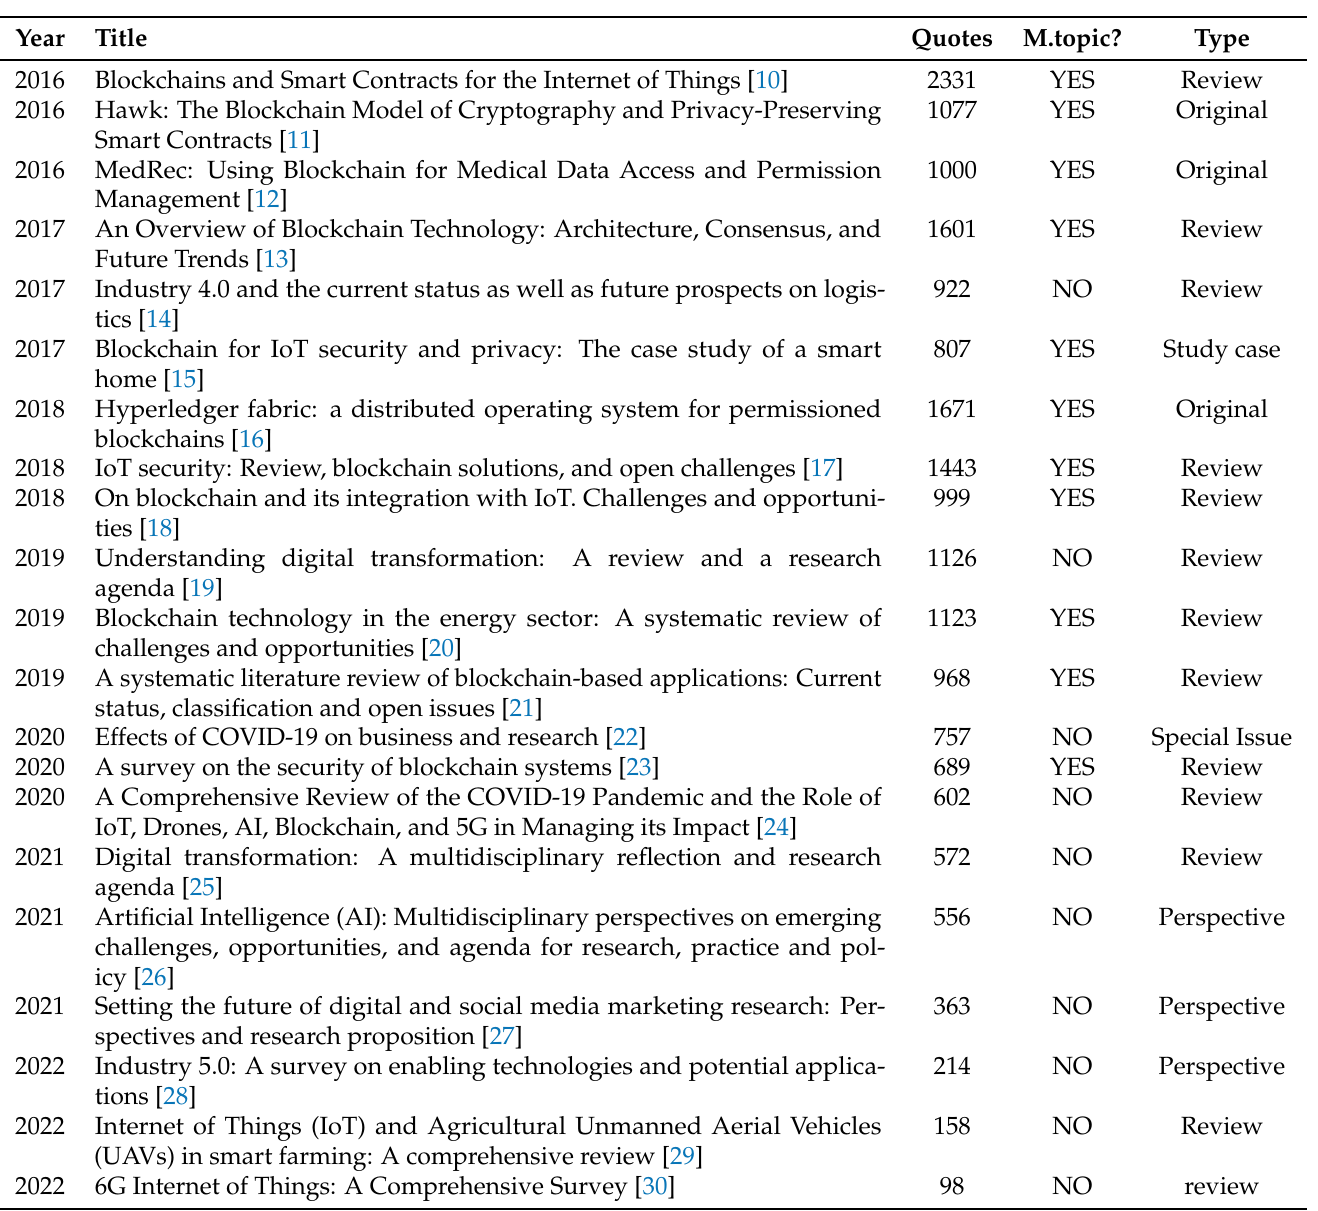
Table 2. Top 3 citations by